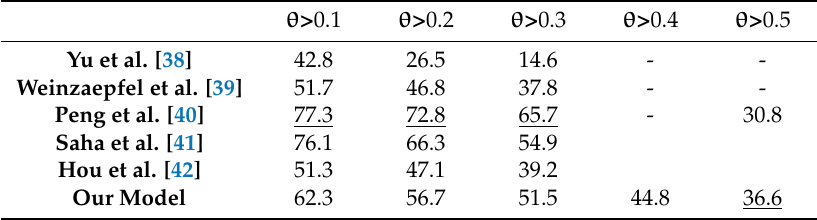
Table 7. Comparison of action-detection performances between different models; UCF-101 dataset. θ > 0.1 θ > 0.2 θ > 0.3 θ > 0.4